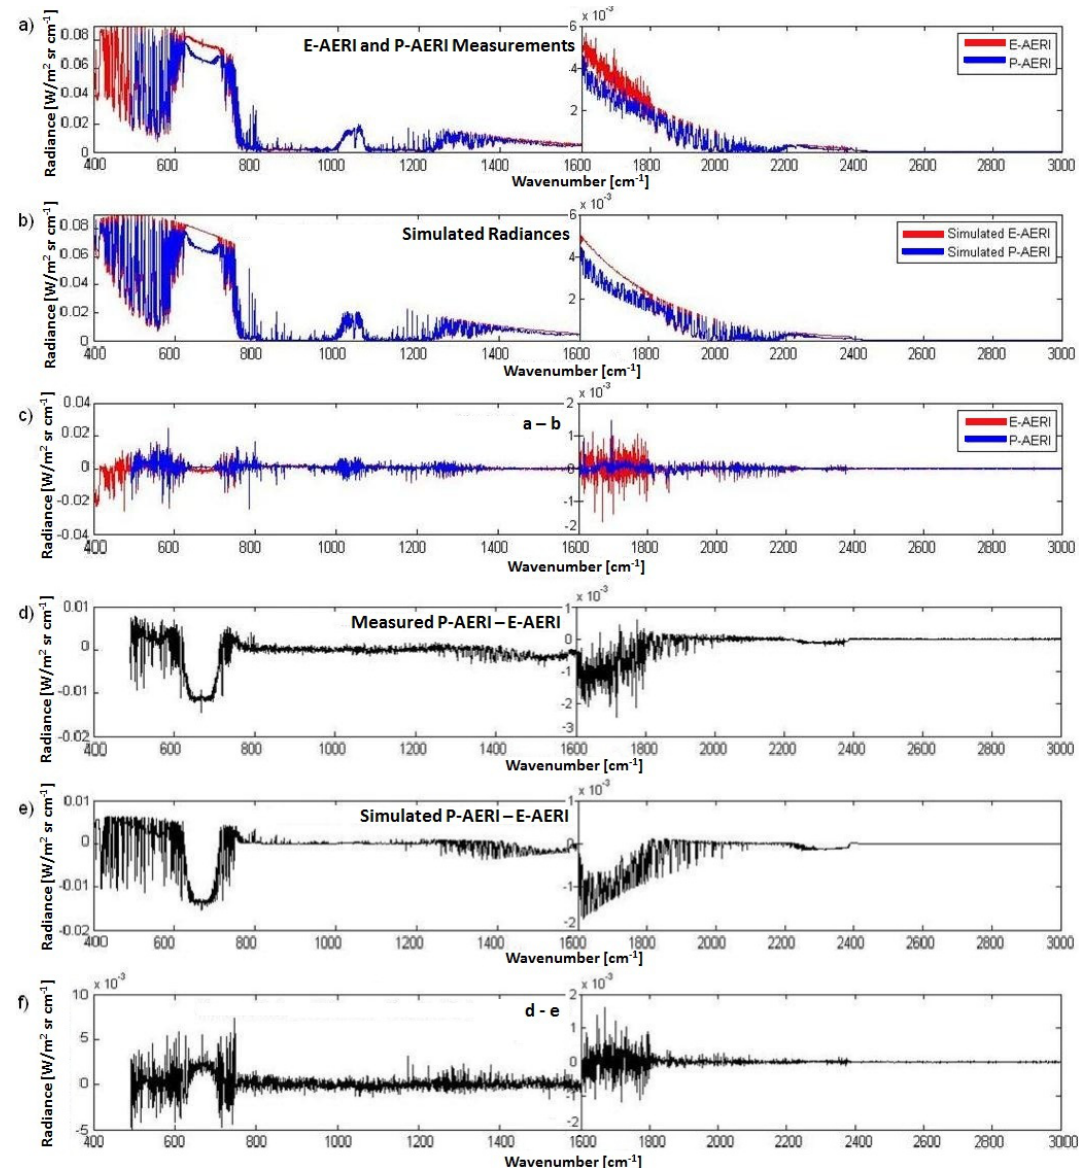
Fig. 9. (a) E-AERI (red) and P-AERI (blue) measured radiances at 00:08(UTC) on 4 April 2009 with (b) simulated spectra shown below. (c) Differences between the measured and simulated spectra for each instrument (a–b) . (d) Measured residuals (P-AERI − E-AERI) with (e) simulated residuals shown below. (f) Differences between the measured and simulated radiance differences (d–e)